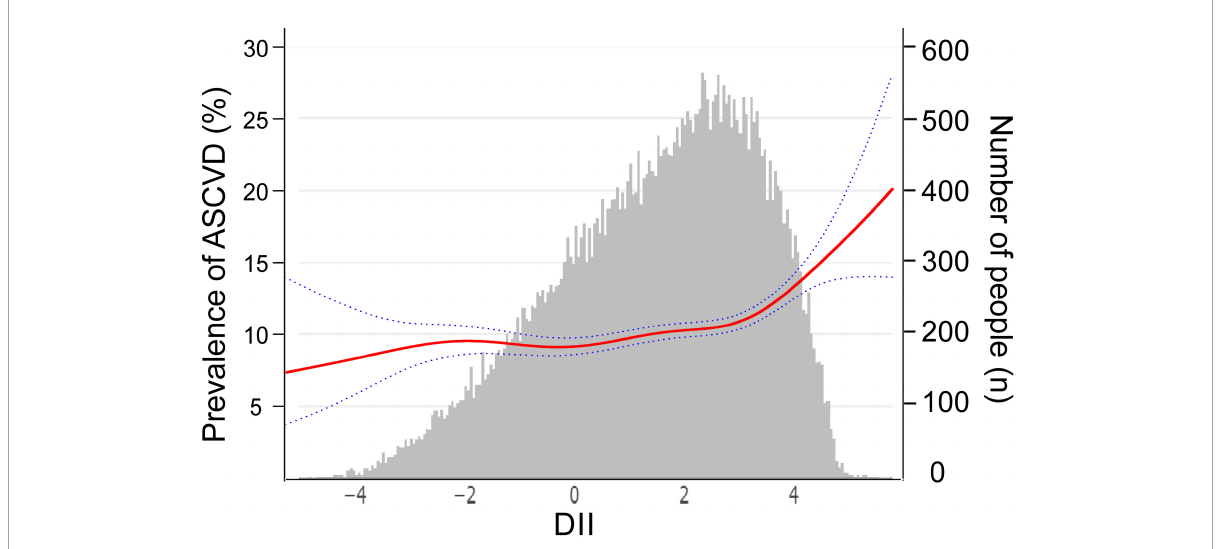
FIGURE2 The relationship between dietary inflammatory index (DII) and atherosclerotic cardiovascular disease (ASCVD), weighted. The red curve represents the non-linear relationship between DII and ASCVD, and the dark blue dotted lines represent the 95% of confidence interval from the fit, corresponding to the vertical coordinate on the left. The gray histogram shows the DII distribution of participants, corresponding to the vertical coordinate on the right. We adjusted age, sex, race or ethnicity, body mass index, education level, smoking status, poverty, insurance, hyperlipemia, hypertension, and diabetes.